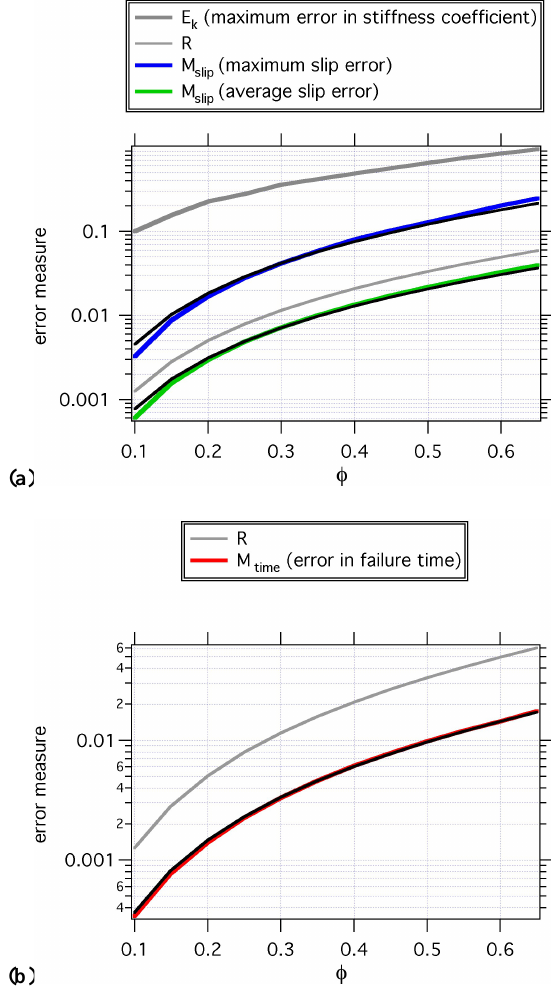
Fig. 7. Errors in the BHM for nucleation using the Barnes-Hut scheme as φ is varied between 0.1 and 0.65. (a) Errors associated with the stiffness coefficients ( E k , Eq. 7 thick grey line) and with fault slip ( M , blue and green). The M are from the numerical sim- ulations. Shown also is R (Eq. 8, grey) which is the ratio of the maximum parent stiffness coefficient to the maximum stiffness co- efficient. The black curves are fits of the form of R to the observed maximum and average errors in slip. These correspond to 3.6 R and 0.62 R . (b) . Errors associated with time of failure ( M , red). These are from the numerical simulations. Shown also is R (Eq. 8, grey). The black curve is a fit of the form of R to the observed failure time